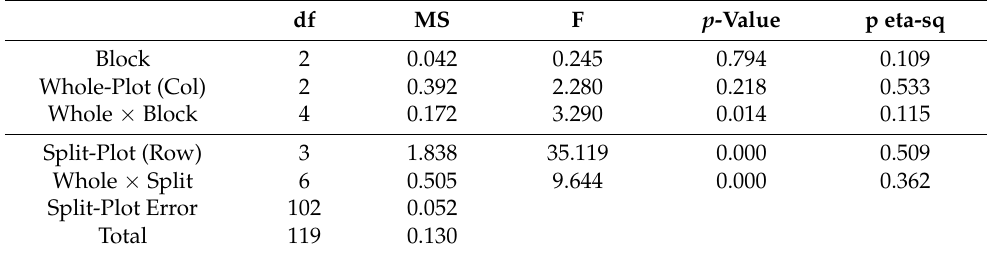
Table 4. Results of split-plot ANOVA for inhalable mass concentration data.